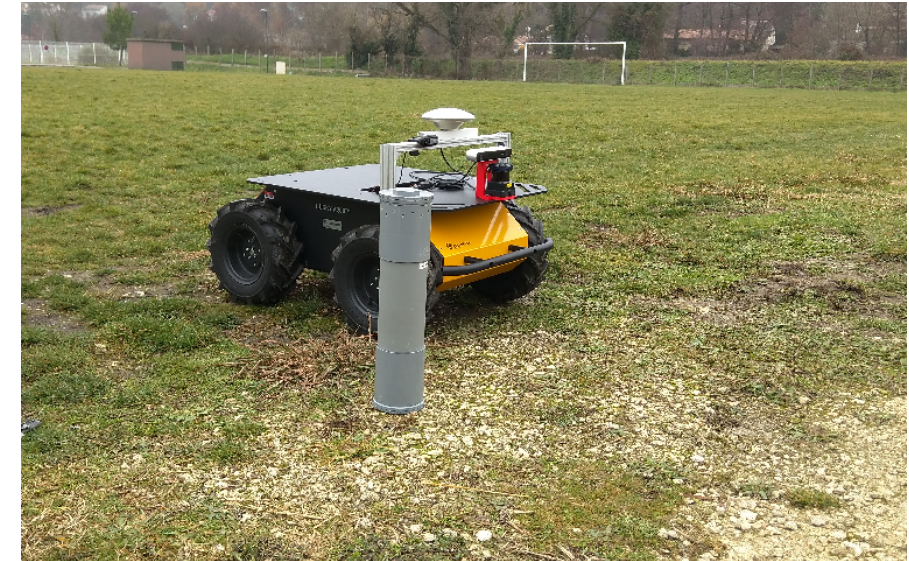
Figure 10. All-terrain mobile platform running ASAWoO next to the base station kit.